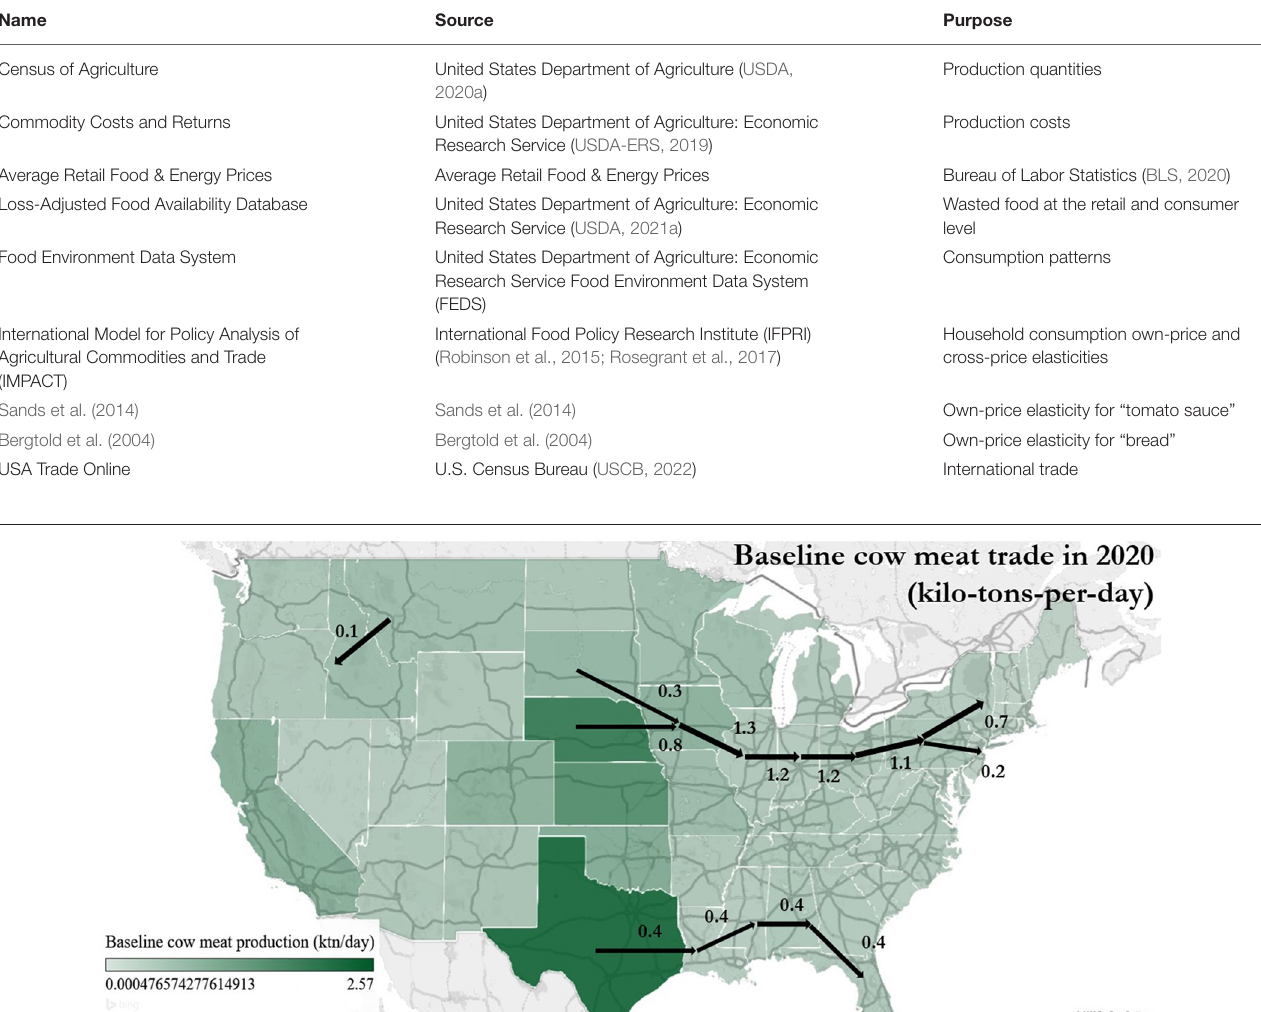
TABLE 2 | Main data sources for US-FEAST food component.